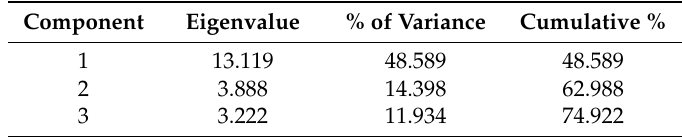
Table 1. Principal components and extracted sums of variance measures in geese.